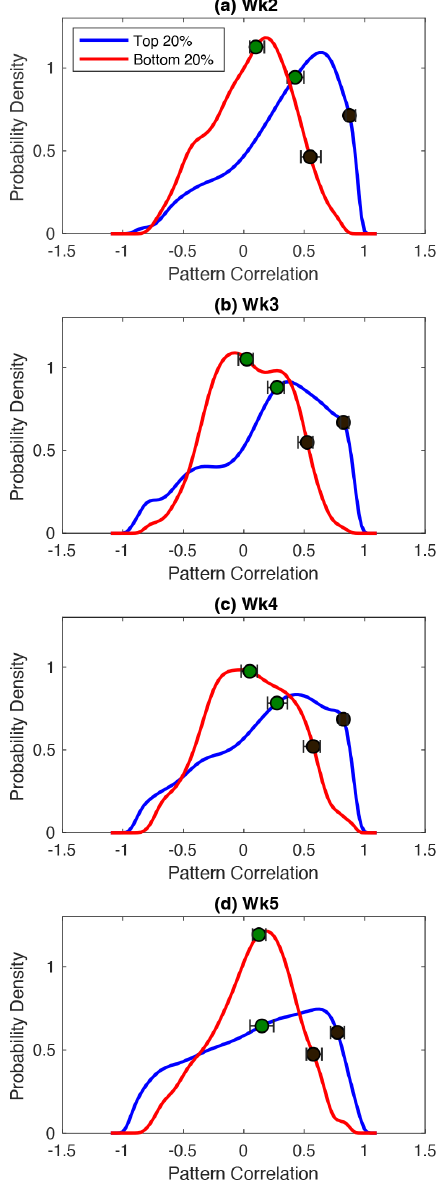
Figure 2. PDFs of actual skill measured by pattern correlation (PCC), for the top 20% and bottom 20% of expected-skill dates for weeks of lead times (a) 2 to (d) 5. The green circles represent the bootstrapped median values, and the black circles represent the bootstrapped 95th-percentile values.